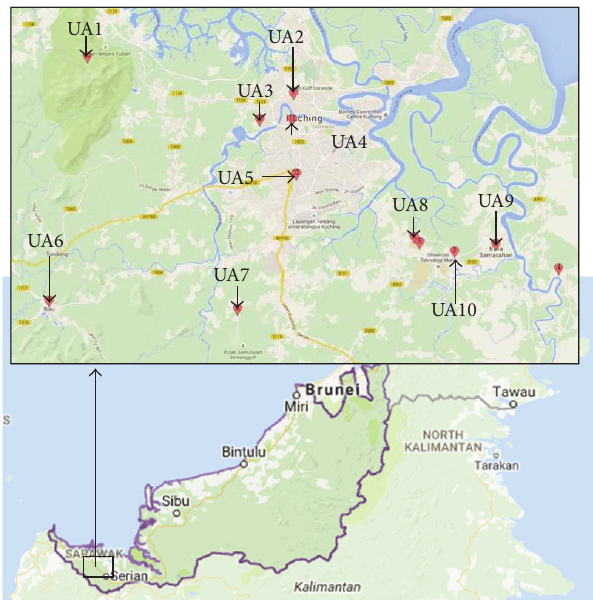
Figure 1: Location of all the urban areas (UA) examined in this study (MapCustomizer, 2016). UA1, UA2, UA3, and UA7 are densely populated villages; UA4 is a famous market near villages; UA5 is a densely populated residential area with prominent hawker centres; UA6 and UA9 are small villages; UA8 is a public university; and UA10 is a residential